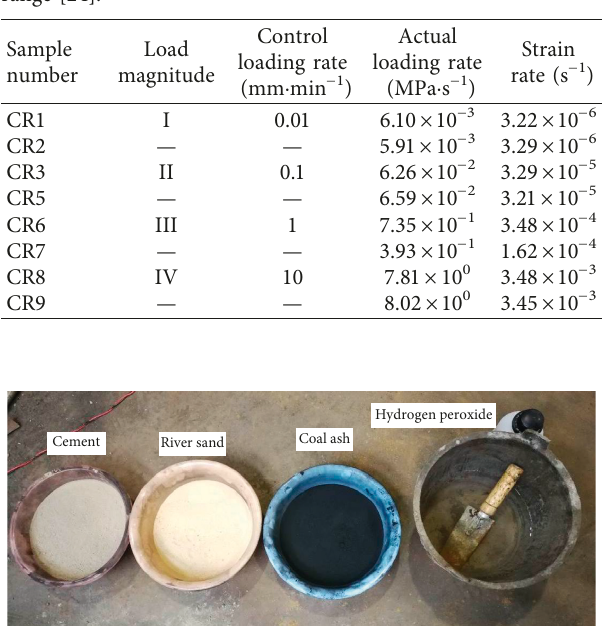
Figure 1: Two typical stress modes of deep engineering rock [25]: (a) one-dimensional force; (b) multidimensional Table 1: Relationship between three loading rates in the static range [24].